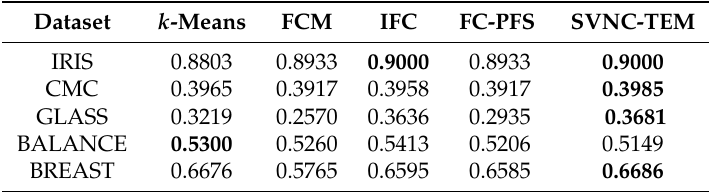
Table 2. The ACC for different algorithms on different datasets.